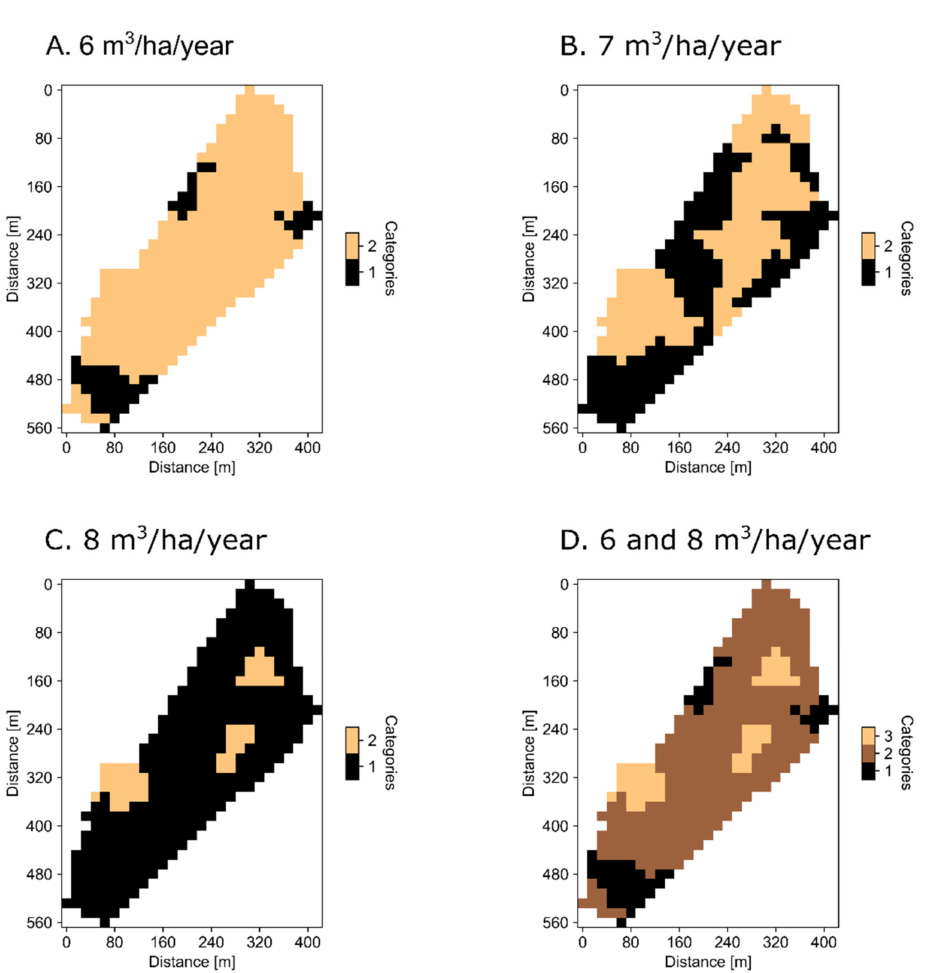
Figure 2. Visualization of micro-stands in study stand no. 49 categorized with single threshold values of 6 ( A ), 7 ( B ) and 8 m 3 /ha/year ( C ) and double threshold values of 6 and 8 m 3 /ha/year ( D ). ( A – C ): Category 1 = Scots pine, 2 = Norway spruce, ( D ): 1 = Scots pine, 2 = Scots pine or Norway spruce and 3 = Norway